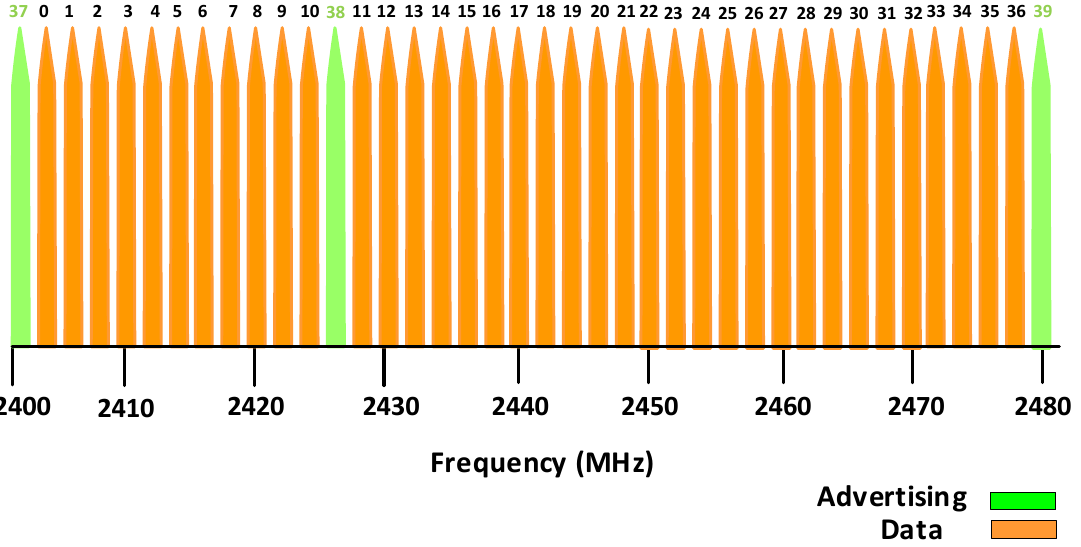
Figure 1. The BLE frequency channels with 37 data transmission channels (orange) and the three advertising channels (green).